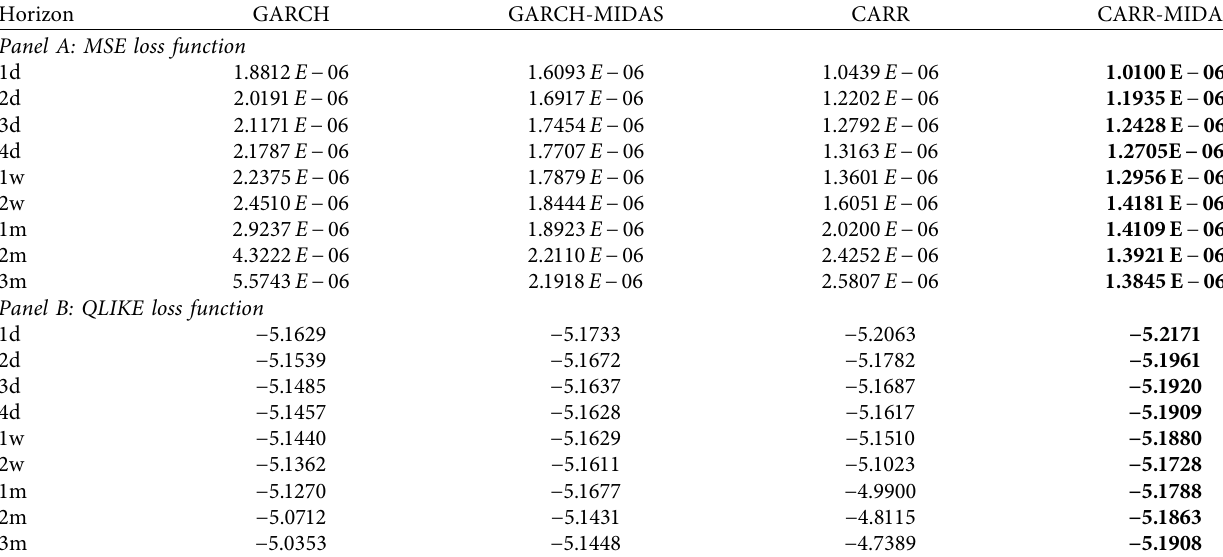
Table 3: Out-of-sample forecast evaluation